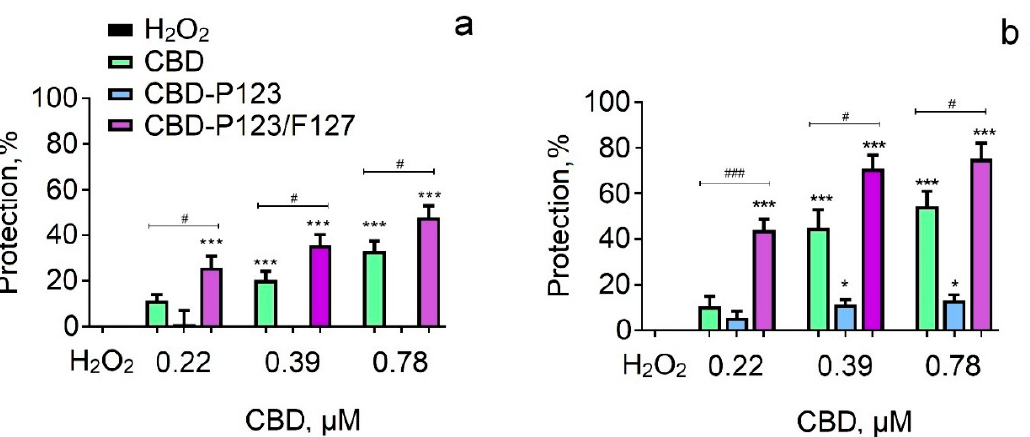
untreated controls and expressed as mean ± SD ( n = 6). ** p < 0.01, *** p < 0.001 vs. control.